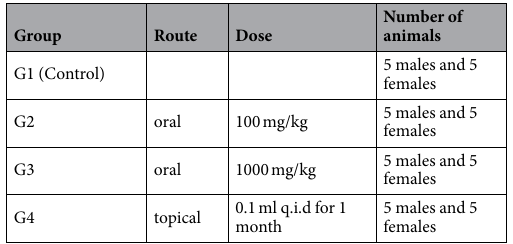
Table 1. Groups, route of administration and dose levels of silica nanoparticles.